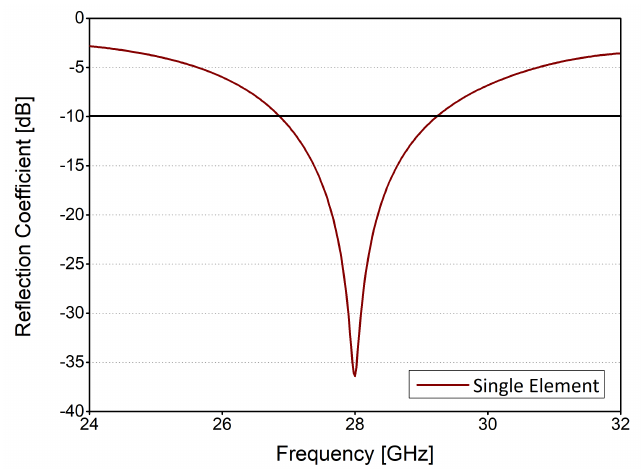
Figure 4. Simulated S-parameter of the single